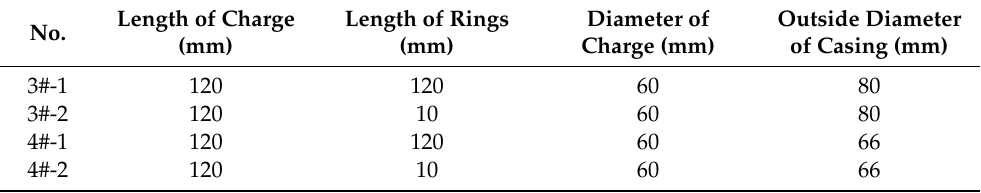
Table 3. Parameters of the additional two sets of specimens.